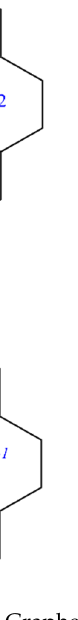
Figure 7. Graphene structure with 𝑙 = 1,𝑘 > 1 .